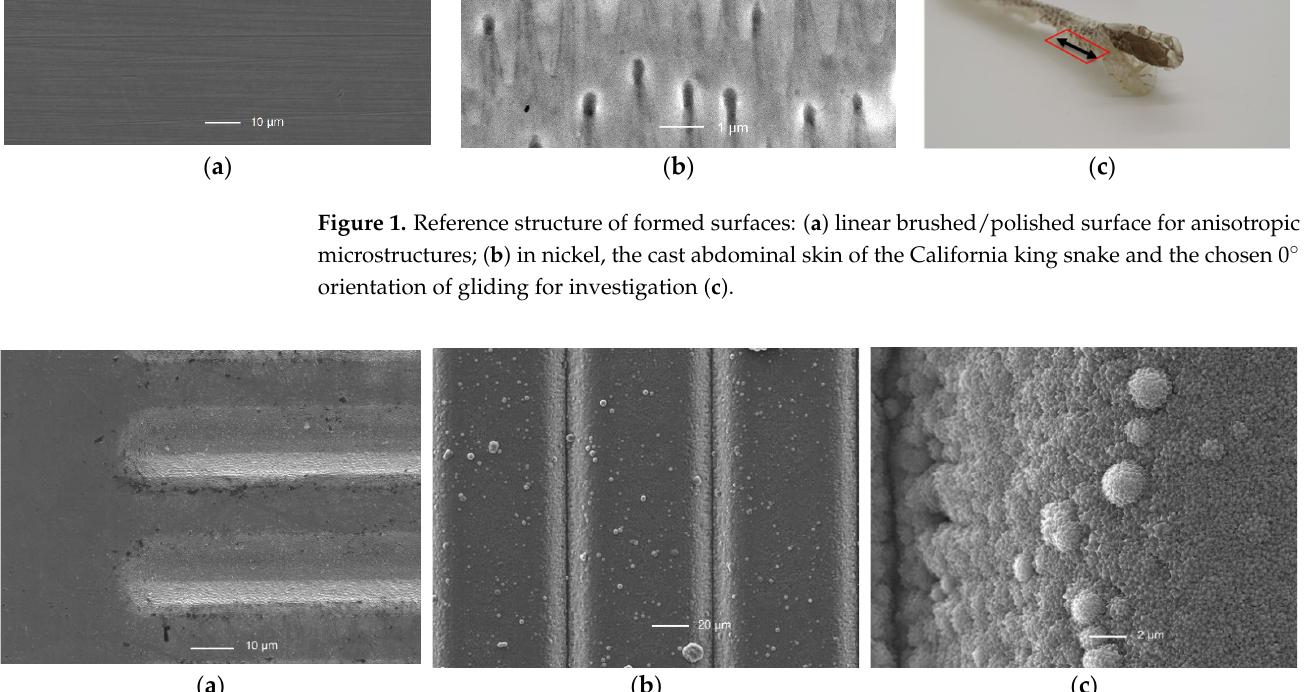
( c ) Figure 3. PVD nanostructure: ( a ) isotropic pyramid structure (diameter ~100 nm), ( b ) isotropic rod structure (diameter ~300 nm) and ( c ) anisotropic pyramid structure. The viscosity of the plastic is decisive for the molding of nanostructures on plastic surfaces, which is determined by the temperature. In LSR processing by injection molding, a cold molding compound (20 °C) is injected into a hot cavity (130 °C–200 °C). Due to the high temperature in the mold, the plastic begins to cross-link, and the viscosity increases. If the cross-linking is too fast, there is a risk that nanostructures will not be completely molded. In addition to the selection of the optimal processing parameters, an improvement should be achieved through dynamic temperature control; i.e., the mold wall temperature is actively changed during the injection molding cycle. Thus, the cavity is filled at a low temperature, whereby structurally accurate nanostructures are formed. At the end of the filling process, the mold wall temperature is increased so that the plastic cross-links [28]. For the variothermal molding of microstructures, high molding quality can be measured. This was checked with the accuracy of the impressed linear grooves (Figure 4).